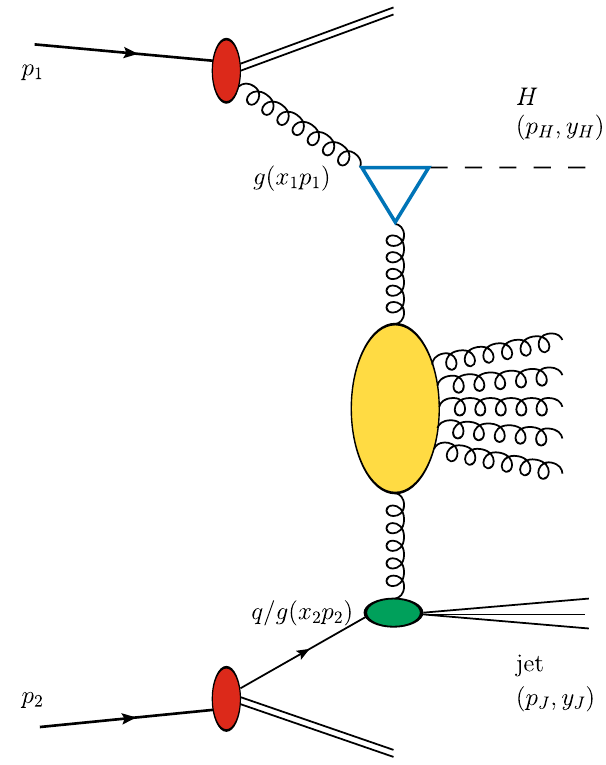
Fig. 1 Schematic representation of the inclusive Higgs-jet hadropro- duction